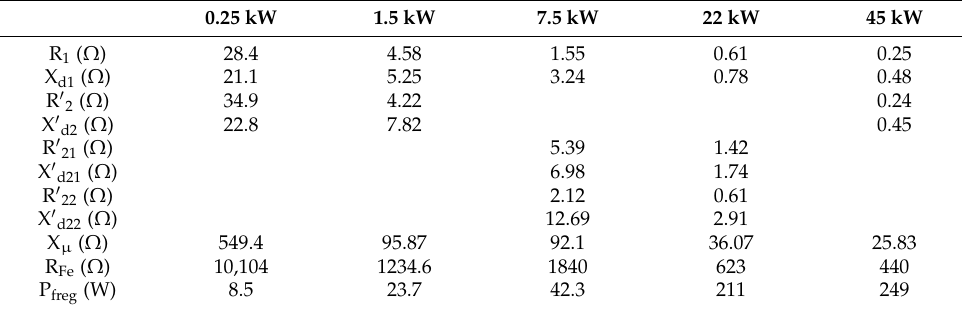
Table 3. Equivalent circuit parameters of the induction